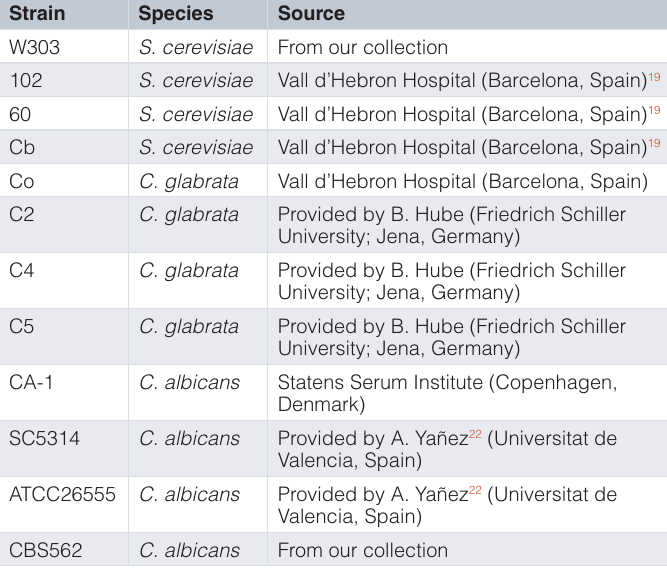
Table 1. Yeast strains used in this